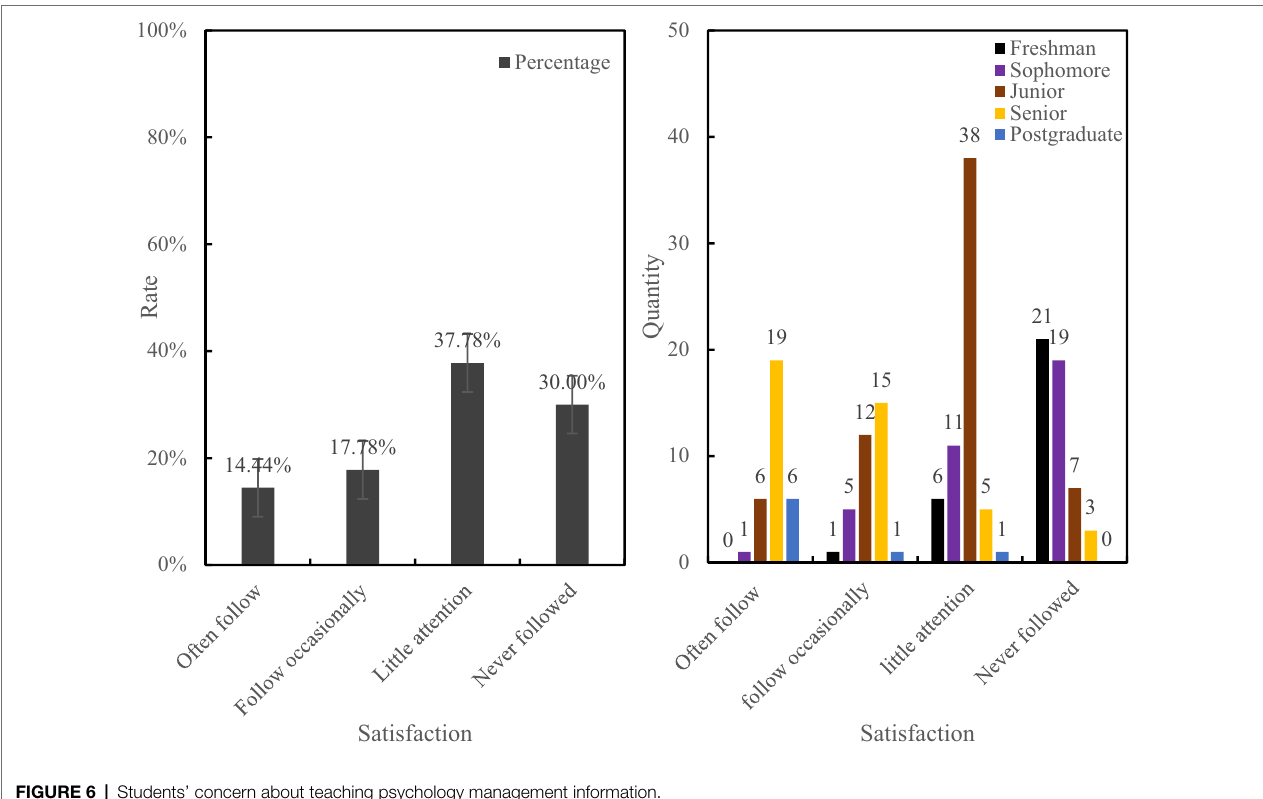
FIGURE 6 | Students’ concern about teaching psychology management information.